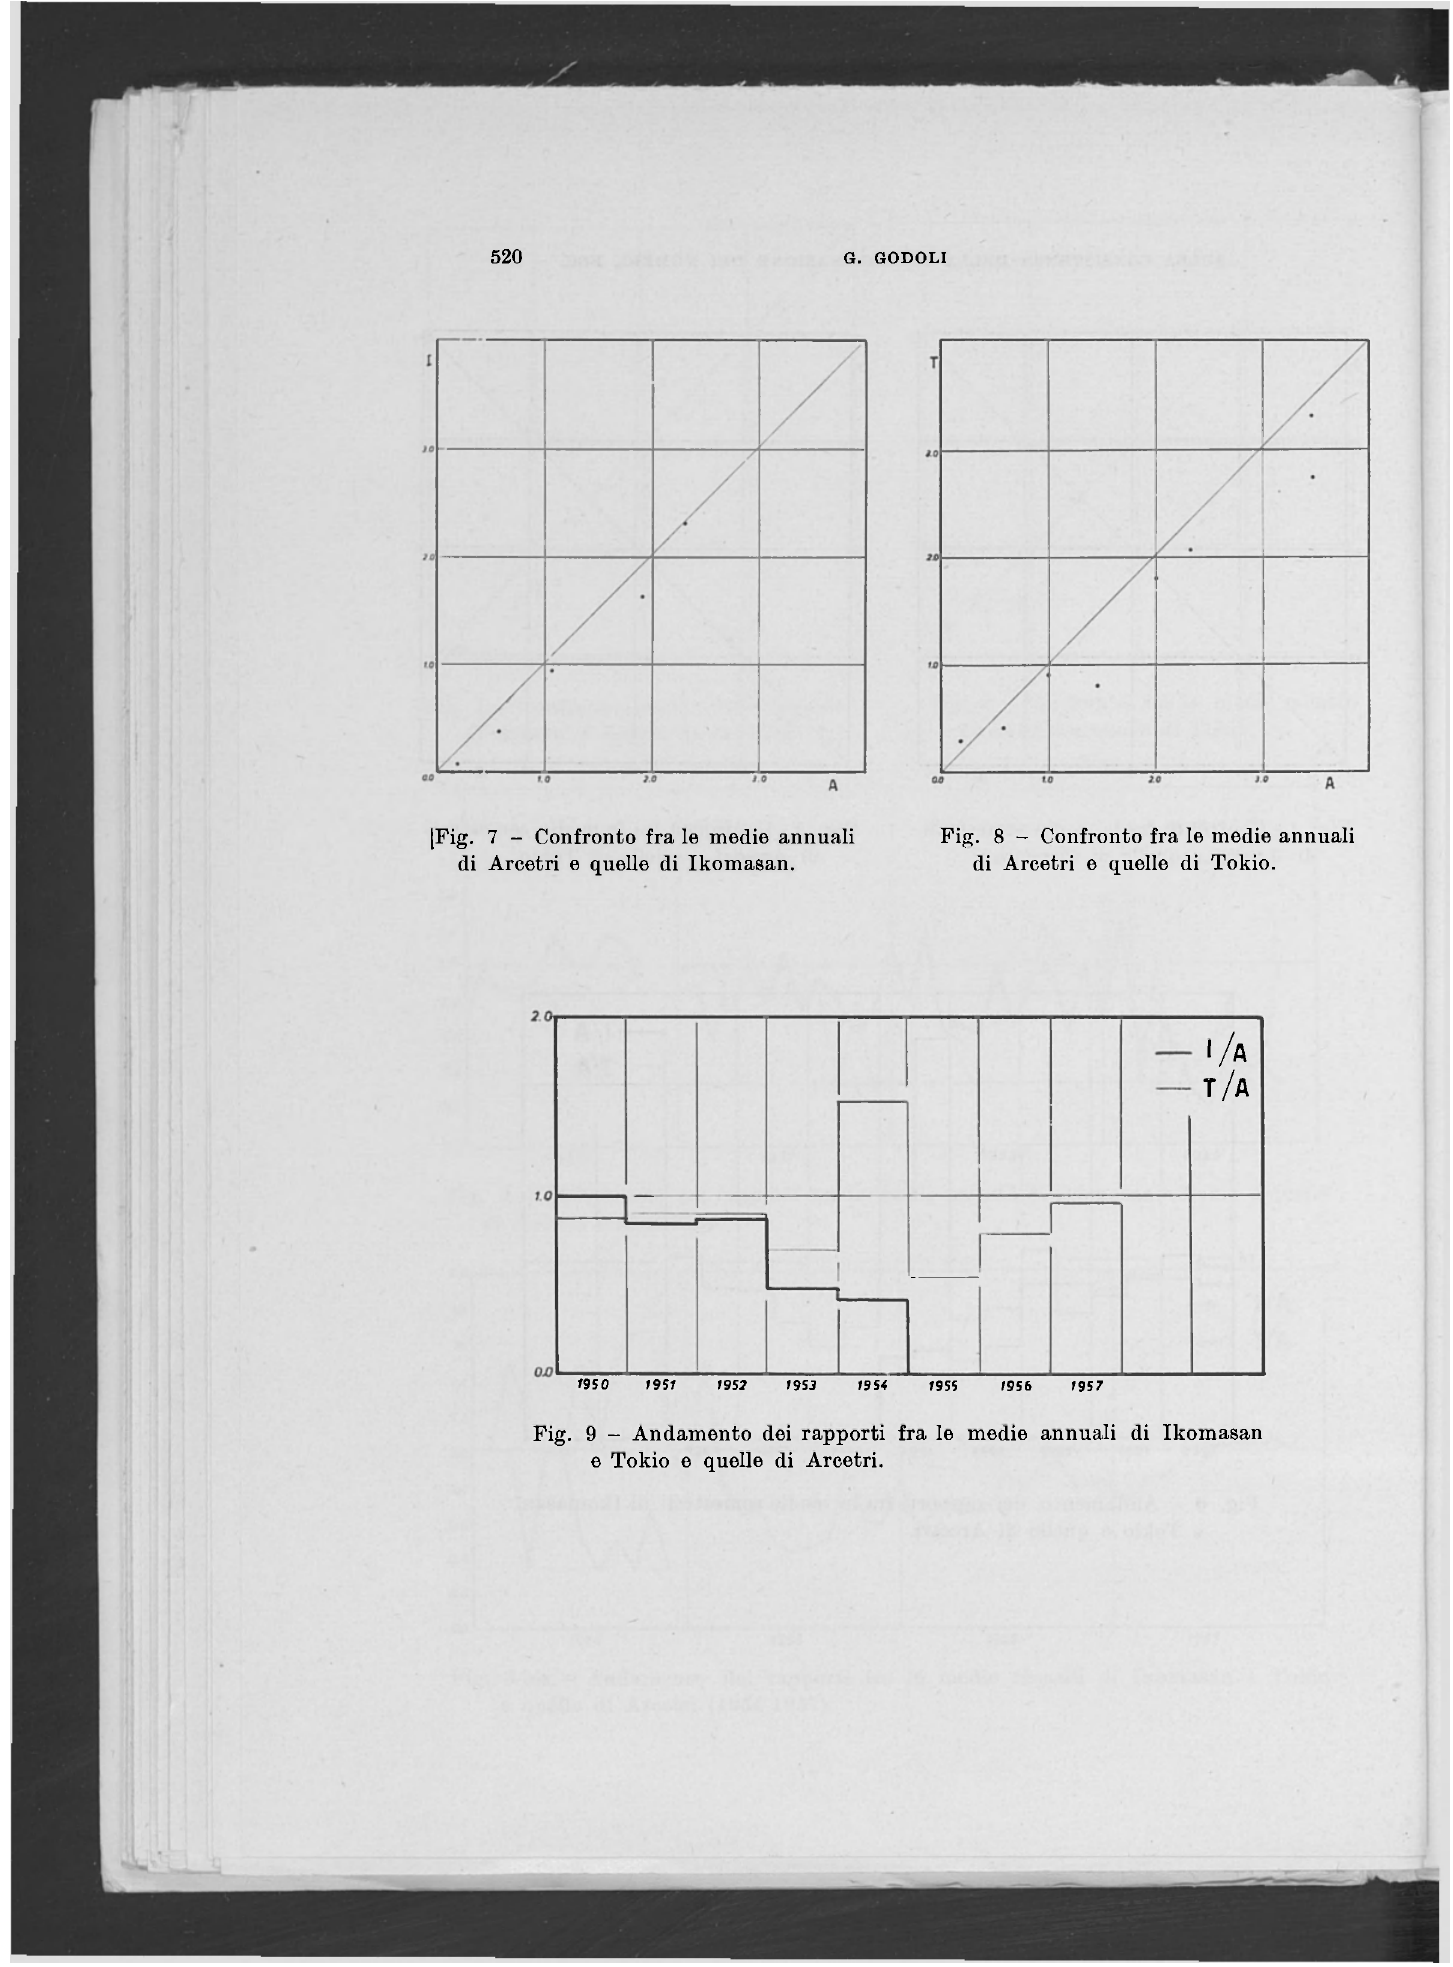
Fig. 9 - Andamento dei rapporti fra le medie annuali di Ikomasan e Tokio e quelle di